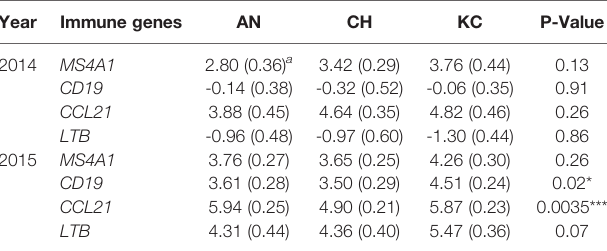
TABLE 4 | Quanti fi cation for relative expressions of four host gene among breeds and differed RFI using qRT-PCR for rectal tissue samples collected in 2014 and